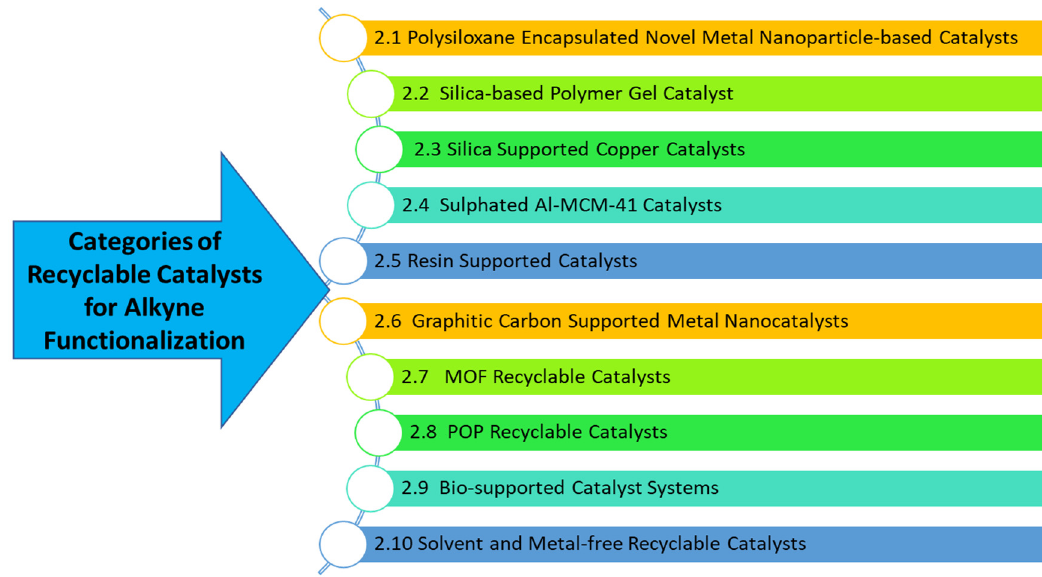
Figure 1. Categories of recyclable catalysts in alkyne functionalization highlighted in this review. Additionally, amongst the highlighted catalysts, a variety of alkyne functionalization reactions have been studied to yield several functionalized products, such as symmetrical and unsymmetrical 1,3-diyne motifs, vinyl silanes, dihalogenated ketones, cross-coupled functionalized alkynes, 1,4-disubstituted-1,2,3-triazoles, polytriazoles, propargylamines, 1,2,3-triazoles, 1-haloalkynes, alkylidenefuranones, thioesters, and others (Figure 2).